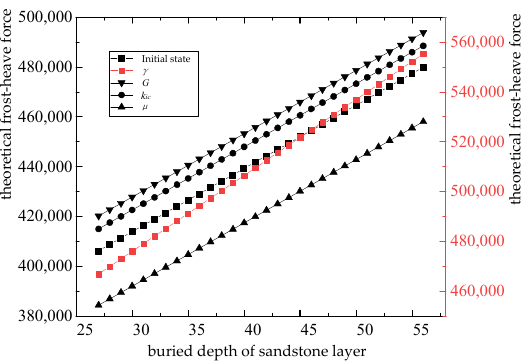
Figure 4. Sensitivity analysis of fixed parameters with buried depth.